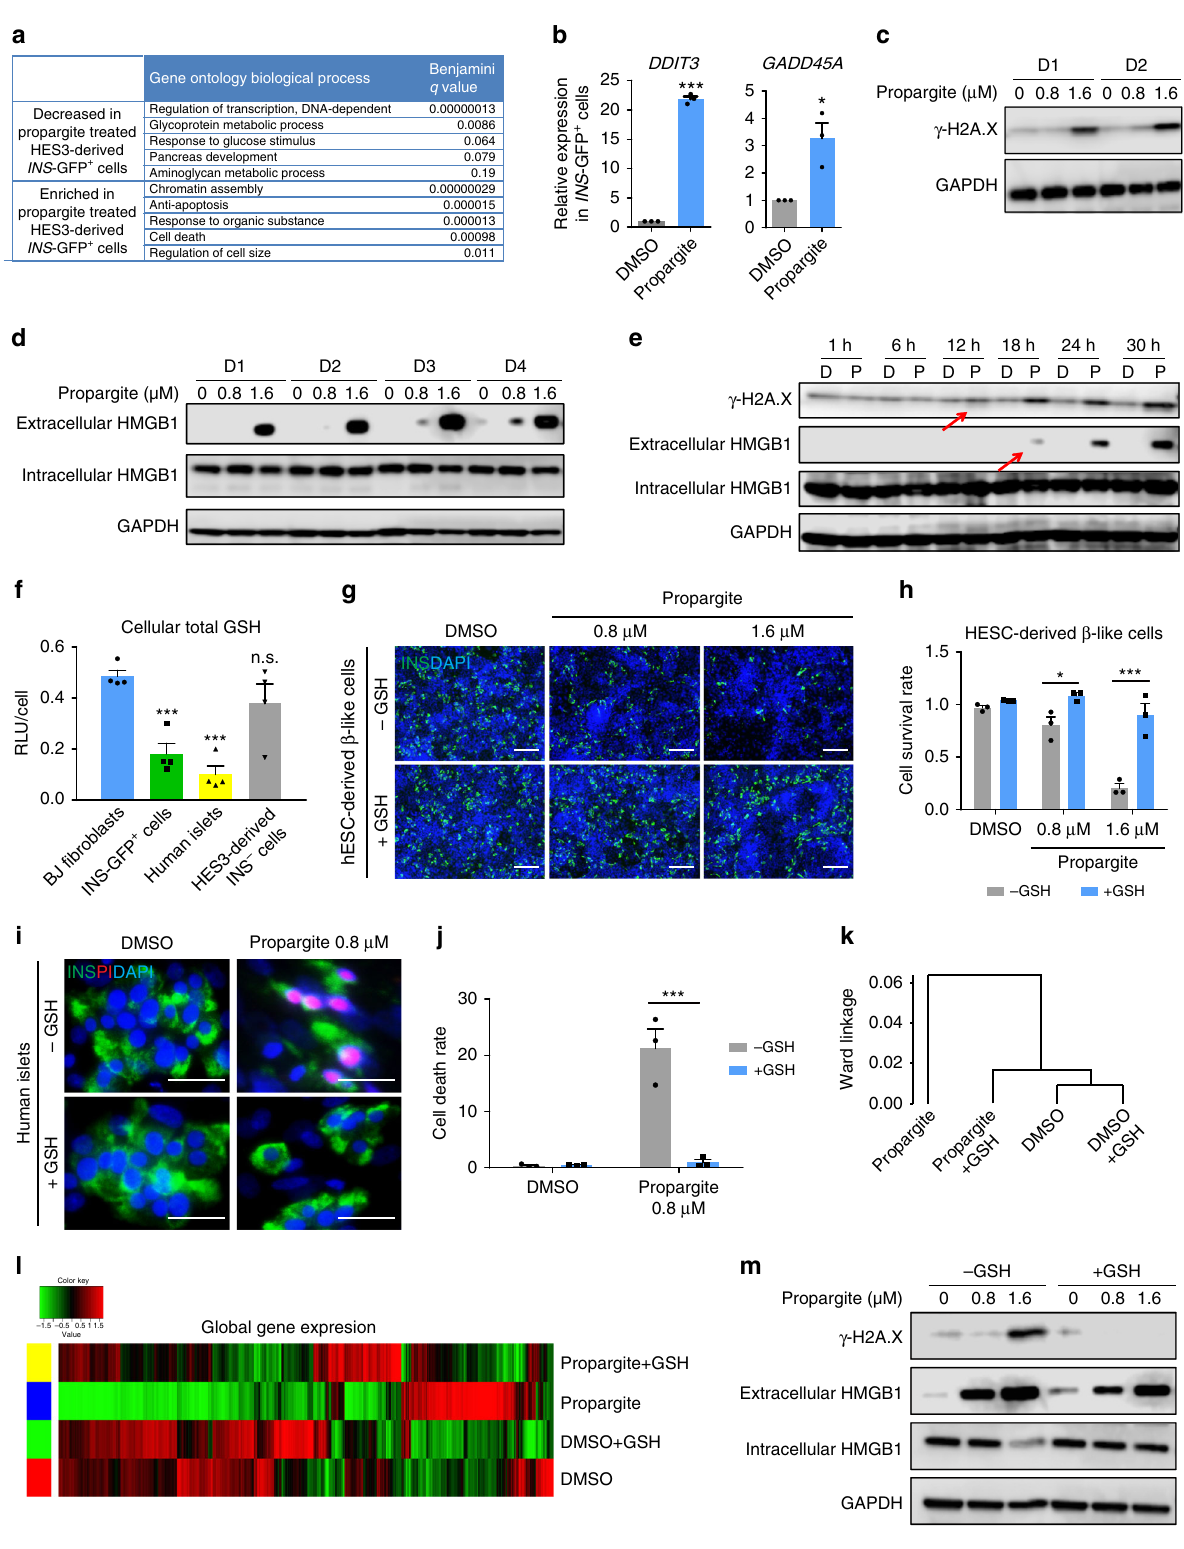
early frameshift that generated null alleles as con fi rmed by wes- tern blotting experiments in mutant hESC-derived cells (Fig. 3d). The wild type (WT), GSTM1 − / − , and GSTT1 − / − hESCs had similar capacities to differentiate into INS + cells as monitored by intracellular FACS (Fig. 3e), suggesting that the GSTM1 − / − and GSTT1 − / − mutations did not affect differentiation to INS + cells.